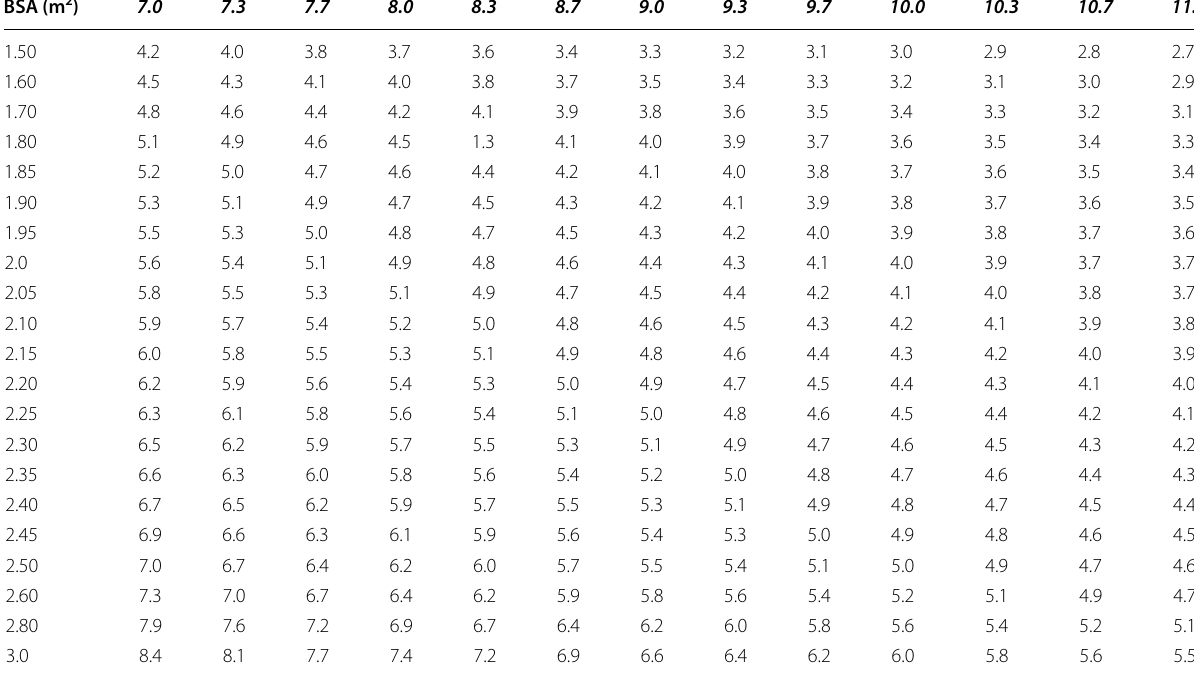
The flow shown (L/min) for a given Body surface area (BSA) and Hb is the minimum required to achieve a DO2i of 280 mL/min/m 2 . All values assume 100% arterial saturation and a PaO2 of 200 mmHg. (Proper permission has been taken to reproduce this table from publishers)